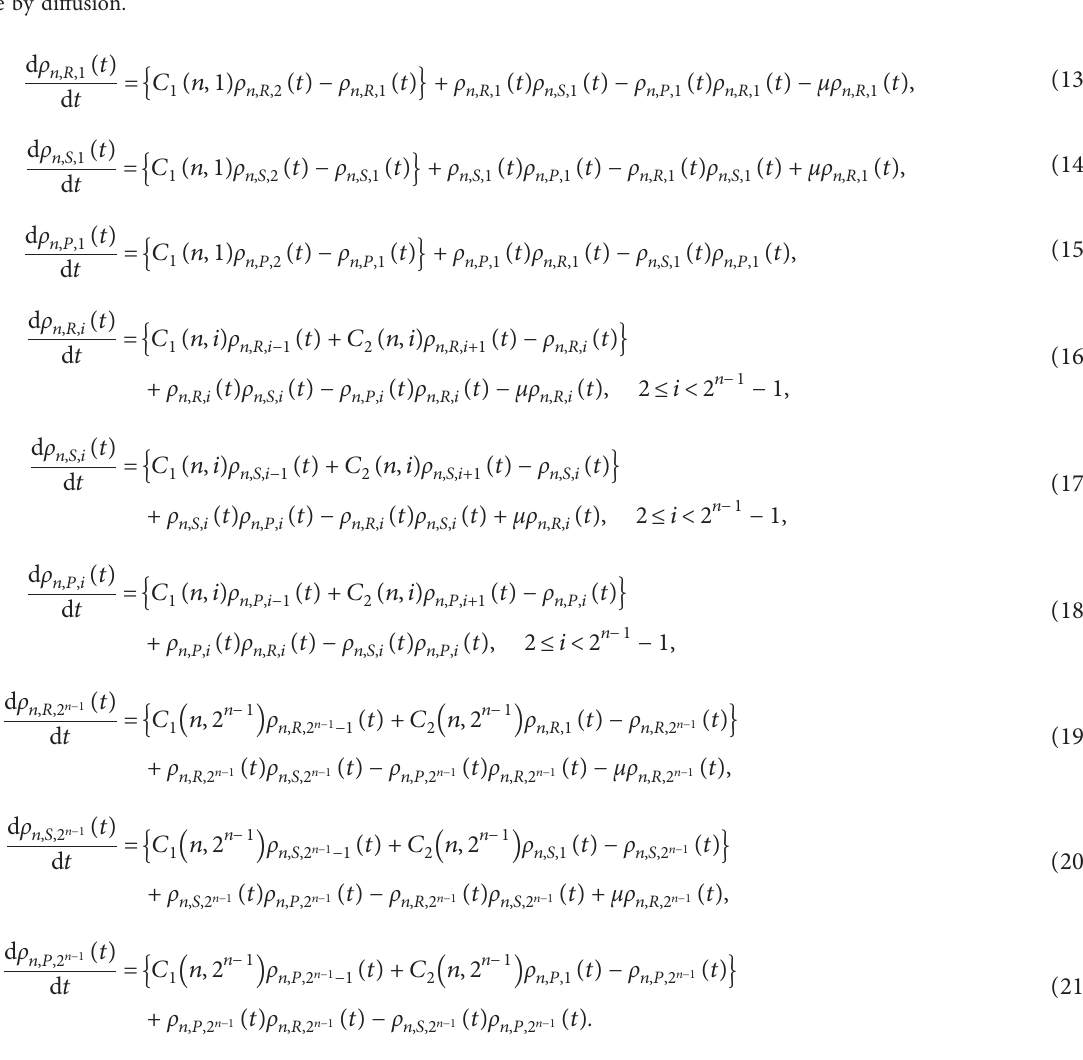
Figure 1: Schematic illustration of the scale-free hierarchical network. (a) First generation of the hierarchical network. (b) Second generation of the hierarchical network. (c) Third generation of the hierarchical network. The n th generation is obtained through repetition. A node represents a patch (subpopulation) in which an RPS game is performed. A link corresponds to a migration path on which RPS individuals move by